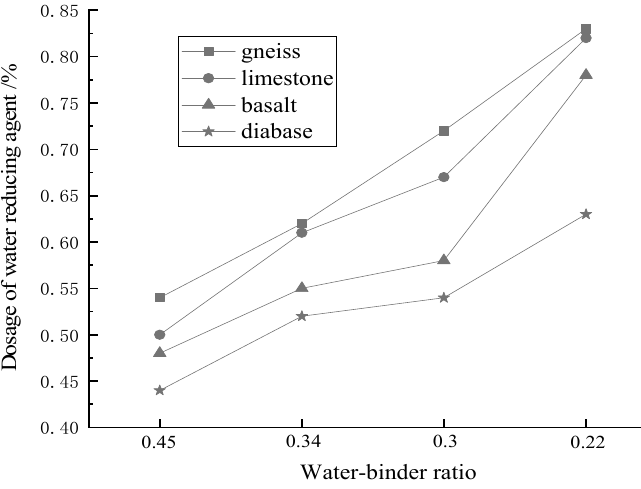
Figure 4. The dosage of a water-reducing agent for cement concrete.